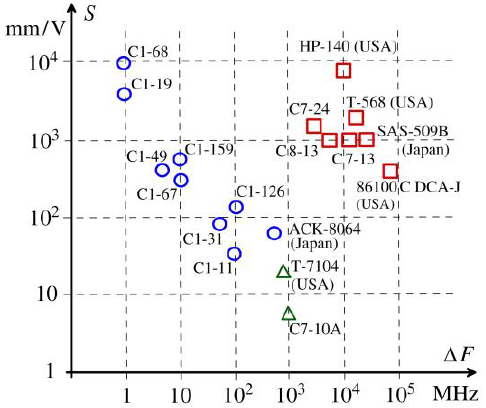
Fig. 1. Sensitivity ( S ) and frequency band (  f ) of some oscilloscope instruments: analog ones (O), TWT devices (  ), stroboscopic ones (  ).